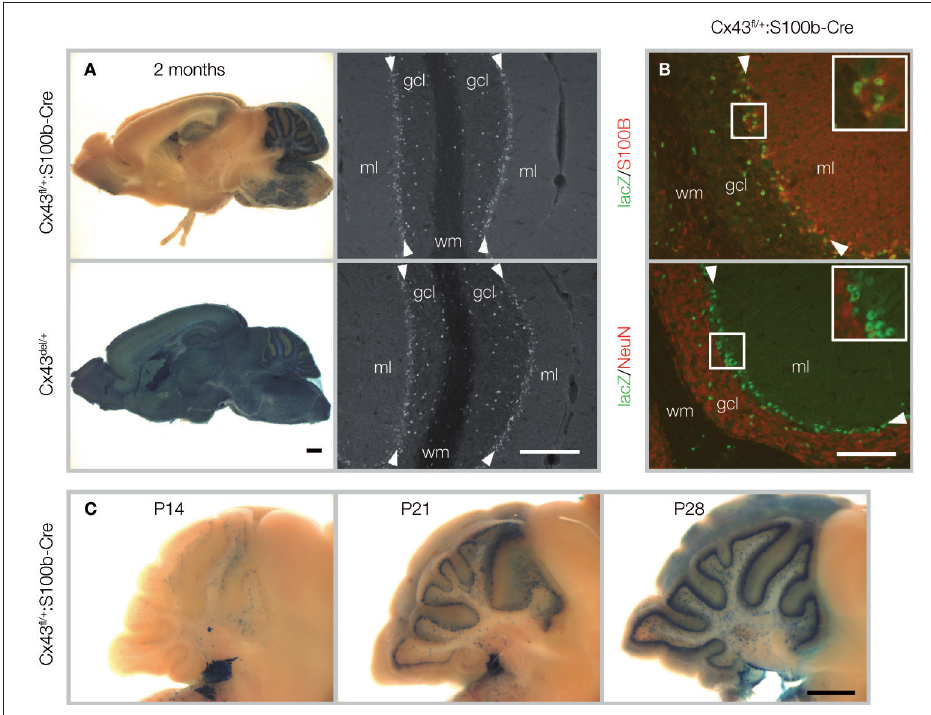
Figure 2 | S100b-Cre - mediated recombination in the brain. (A) Left panels: LacZ staining of 2-month-old Cx43 fl/ + : S100b-Cre mice showing the most extensive Cre-mediated recombination in the cerebellum as compared to positive control Cx43 del/ + mice (Theis et al., 2001). No lacZ-positive cells were detected in negative control Cx43 fl/ + mice (data not shown). Scale bar, 1 mm. Right panels: Immunofluorescence analysis of parasagittal sections of the cerebellum from 2-month-old Cx43 fl/ + : S100b-Cre mice and positive control Cx43 del/ + mice using antibodies directed to β -galactosidase. β -galactosidase immunoreactivity localized in the nucleus is observed in the Purkinje cell layer (arrowheads), granule cell layer (gcl) and white matter (wm). ml, molecular layer. Scale bar, 200 μ m. (B) Double-immunofluorescence analysis of parasagittal sections of the cerebellum of Cx43 fl/ + : S100b-Cre mice. Nuclear lacZ immunoreactivity that colocalizes with S100B and not with NeuN corresponds to Bergmann glial cell bodies (magnified in inserts) in the Purkinje cell layer (arrowheads) and astrocytes in the granule cell layer. Scale bar, 100 μ m. (C) Time course of S100b-Cre -mediated deletion of Cx43 fl allele in the postnatal cerebellum. Scale bar, 1 mm. Modified and reproduced from Tanaka et al. (2008). Front. Behav. Neurosci. 2,